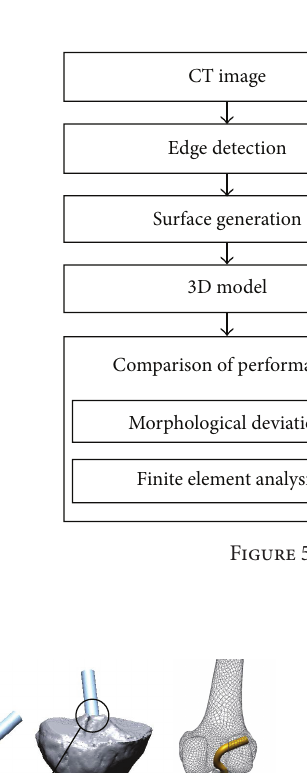
Figure 4: Knee model reconstruction using interpolation.